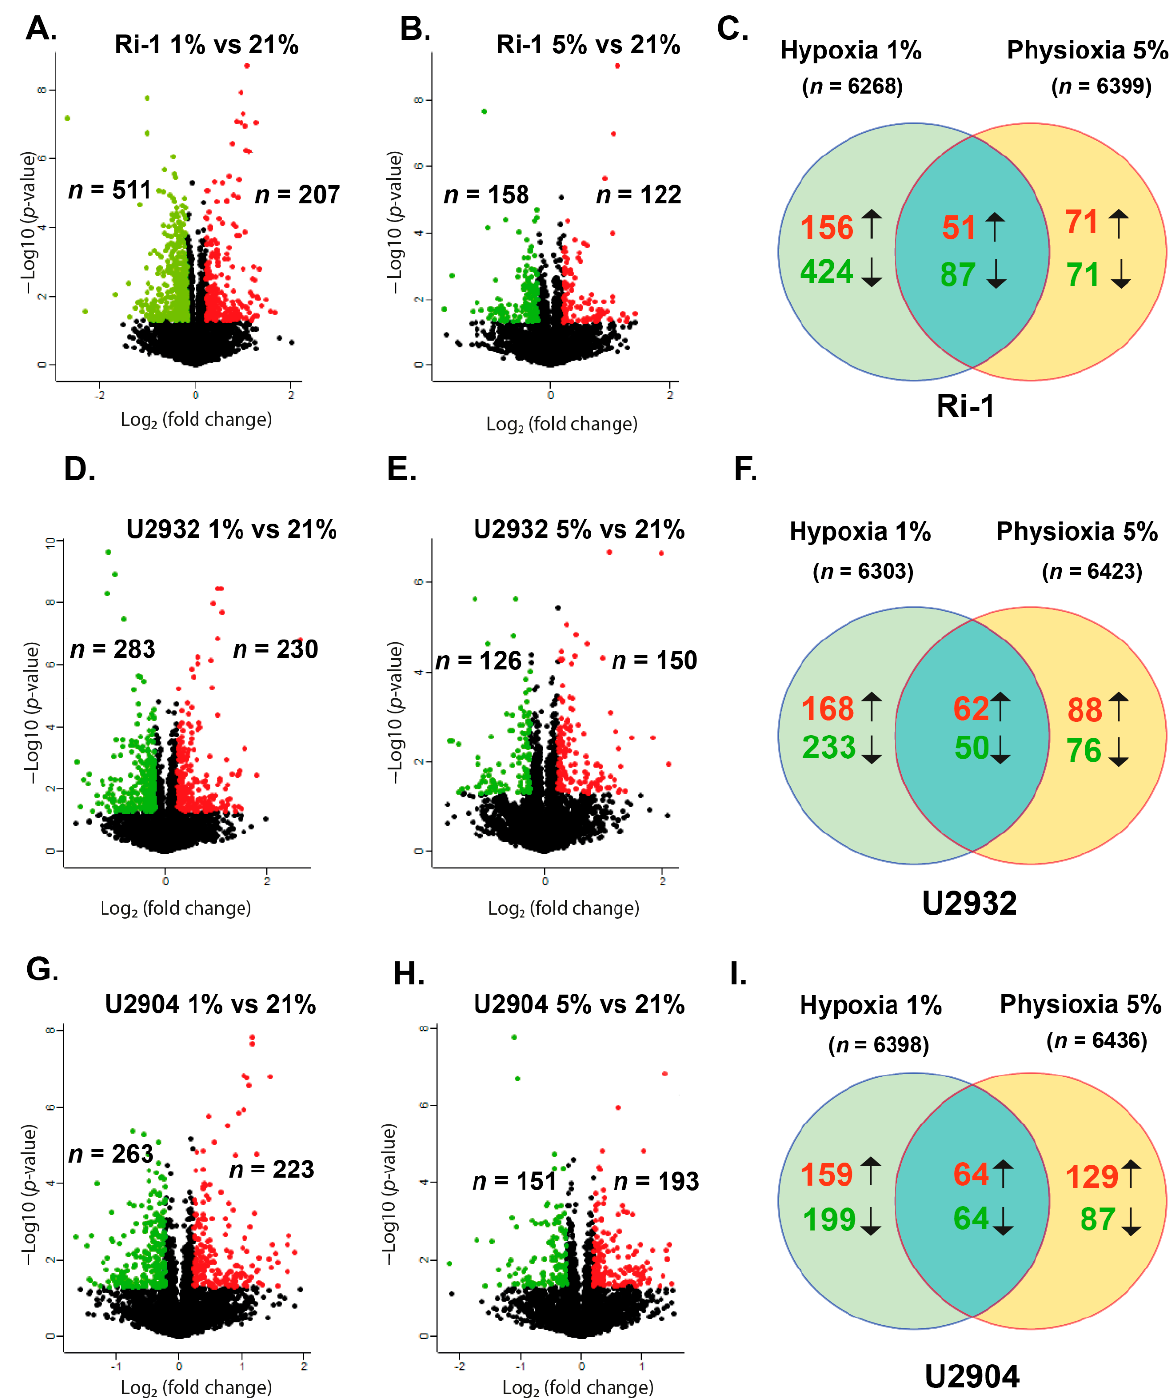
Figure 2. Volcano plots of data from label-free quantification of differentially abundant proteins (DAPs) in ( A ) hypoxic Ri-1 cells, ( B ) physioxic Ri-1 cells, ( D ) hypoxic U2932 cells, ( E ) physioxic U2932 cells, ( G ) hypoxic U2904 cells, and ( H ) physioxic U2904 lymphoma cell lines when compared to normoxia. The number of proteins identified in 100% of biological replicates is provided. Red dots represent upregulated proteins with fold change ≥ 1.5 while green dots represent downregulated proteins with fold change ≤− 1.5, p -value cutoff < 0.05. The number of up- and downregulated proteins is presented. Generated in Perseus software. ( C ) Venn diagram showing the overlap between DAPs identified in hypoxia and physioxia in comparison to standard oxygen conditions in Ri-1 cells, ( F ) U2932 cells, and ( I ) U2904 cells. The complete list of DAPs with all details is placed in Table S2, while lists of shared proteins in hypoxia and physioxia in each cell line are provided in Table S3.